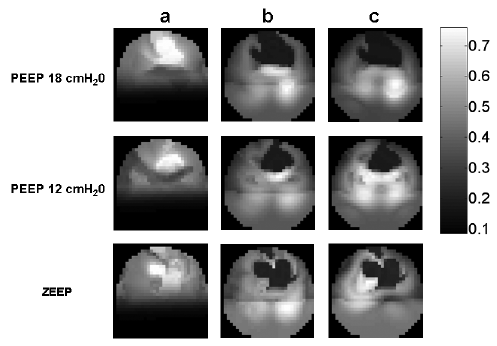
Figure 3 - Gray scale map of fuzzy modeling results: column a ) median heart possibility map; column b ) median lung perfusion possibility map; and column c ) median lung ventilation possibility map. The lines represent the results for PEEP steps: from top to bottom, 18 cm H and ZEEP